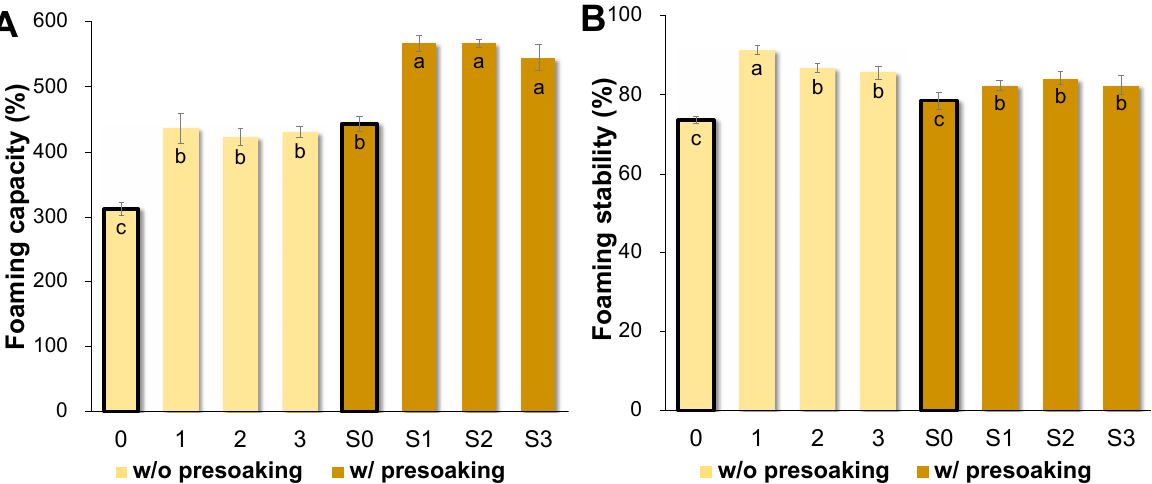
Figure 4. Foaming properties of the AQ produced from chickpea and three Korean soybean cultivars. Bold bar graphs are each group of controls (0 and S0), respectively. Each foaming property value marked with a different letter (a–c) is significantly different ( p < 0.05) from the others marked with a different letter according to Tukey’s test. ( A ) Foaming capacity and ( B ) foaming stability.